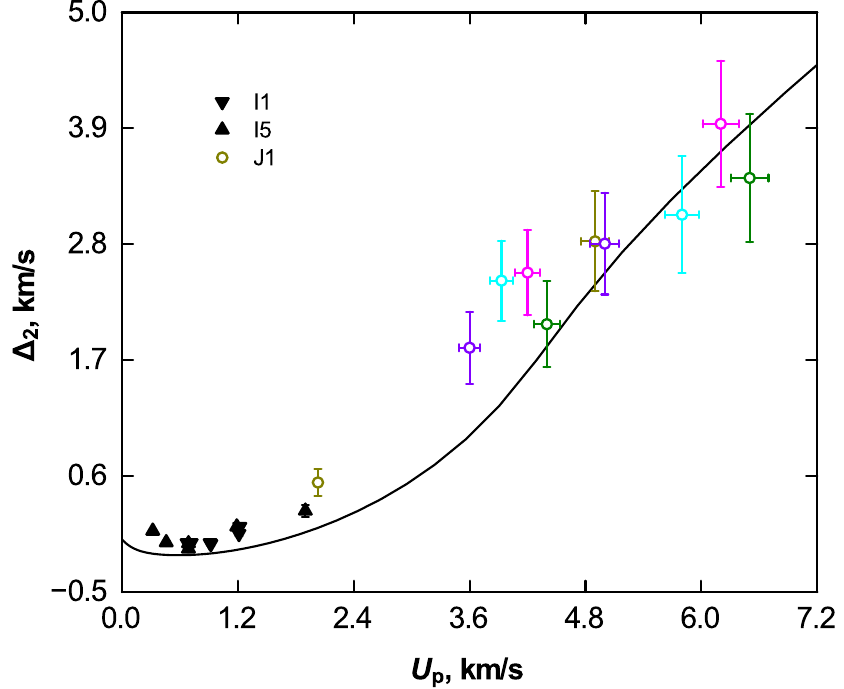
Figure 7. The particle velocity behind the front of the shock wave in air minus twice the particle velocity behind the front of the first shock wave in the bismuth samples ( ∆ 2 = U pair − 2 U p ) as a function of U p ; the designations are the same as in Figure